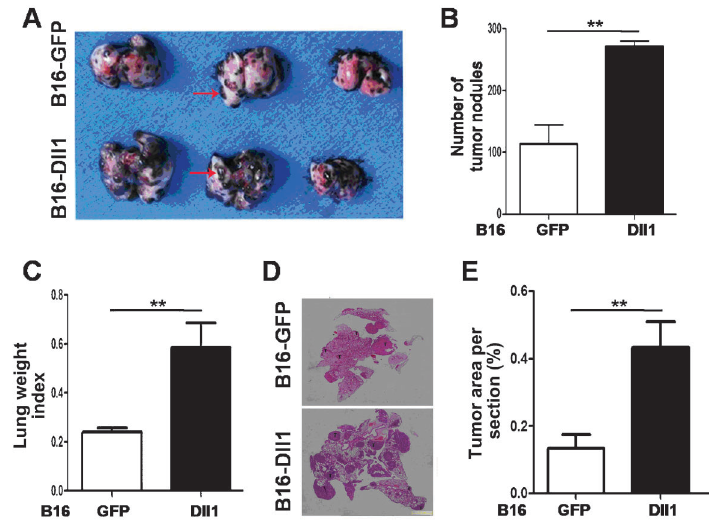
Figure 4. Overexpression of Dll1 promotes tumor metastasis in vivo . A , B16-Dll1 or B16- GFP tumor cells were injected into the tail vein of normal mice. Lungs were dissected and photographed 15 days later. Tumor nodules are observed on the surface of lungs (red arrows). B , Tumor nodules on the surface of the lung were counted under a stereomicroscope and com- pared. C , Lung weight index was calculated as the ratio of lung weight versus body weight of host mice, and was compared between the two groups. D , Lungs in A were sectioned and photographed with H&E staining. T indicates the tumor foci in lungs. E , Tumor area in lung section was assessed by the Image-Pro Plus Phase 6 Imaging System and nomalized to total lung